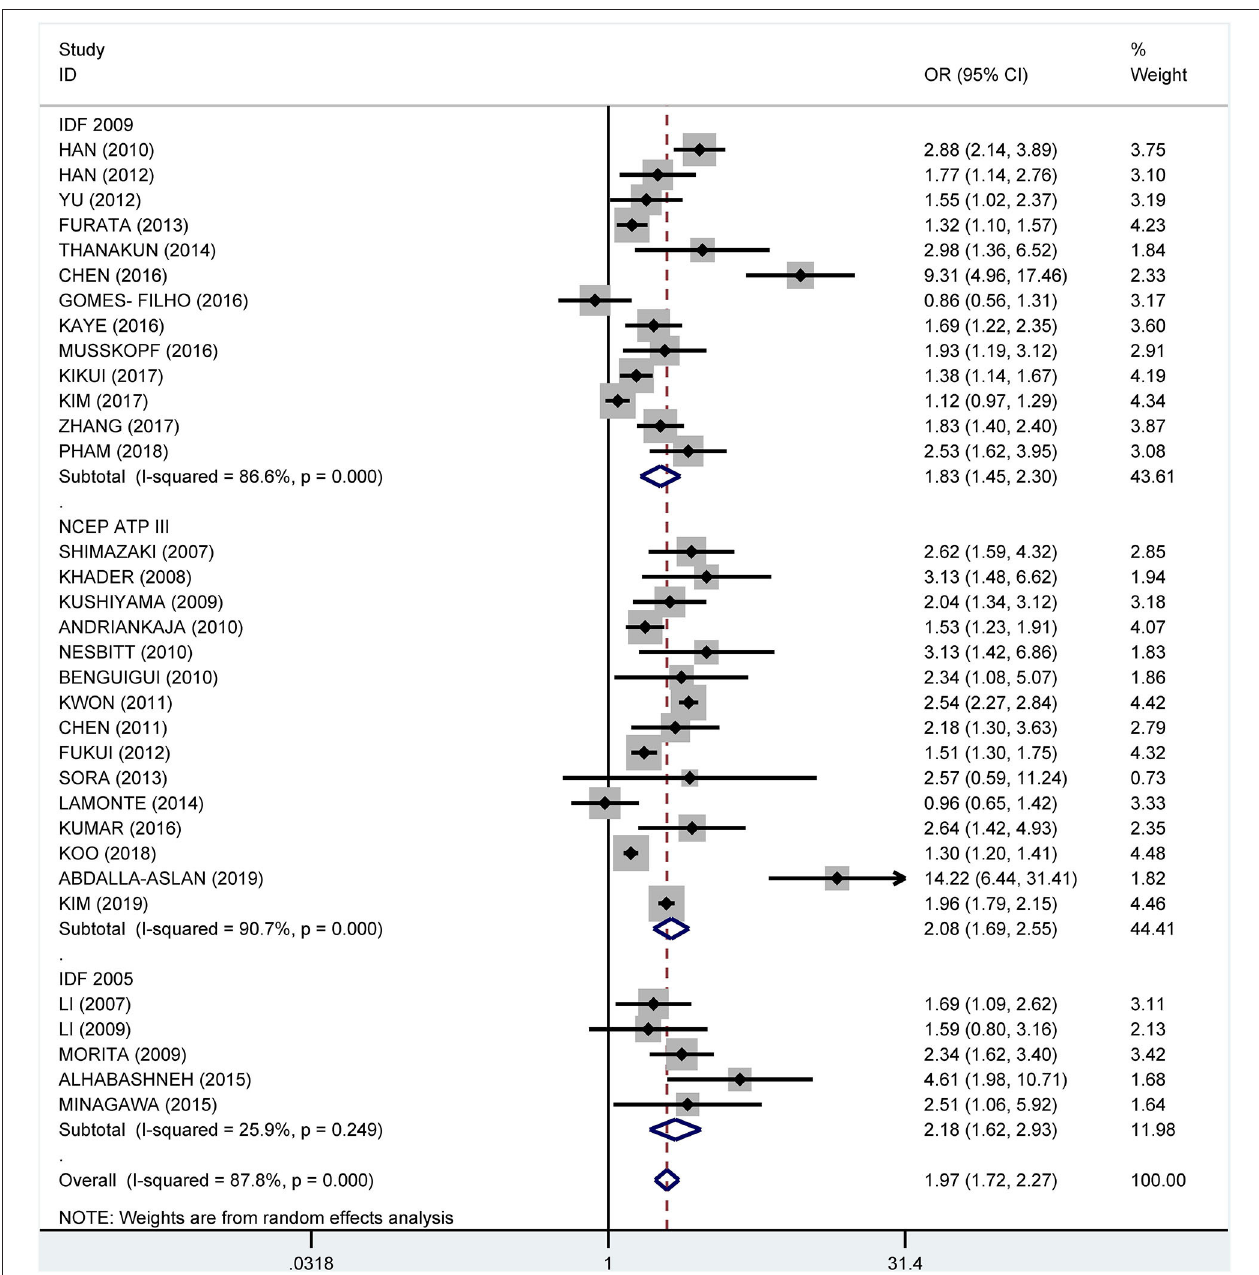
FIGURE 7 | Subgroup analysis of pooled crude odds ratios of the association between periodontitis and metabolic syndrome by diagnostic criteria for metabolic syndrome.